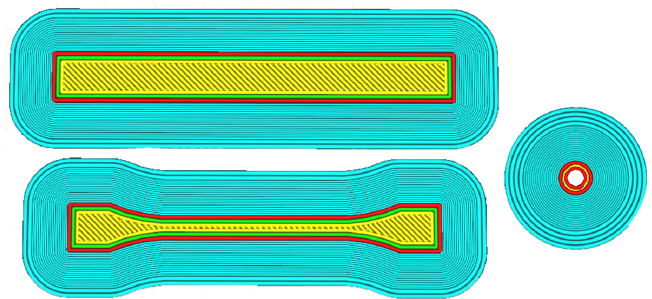
Figure 2. Printing path of straight, dumbbell, and concentric annular-shaped samples.